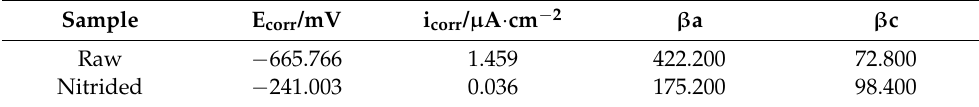
Table 2. Electrochemical parameters calculated according to the polarization curves in Figure